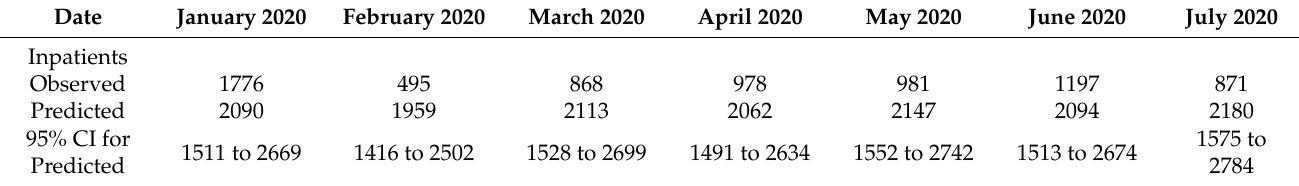
Data are shown as number or 95% uncertainty